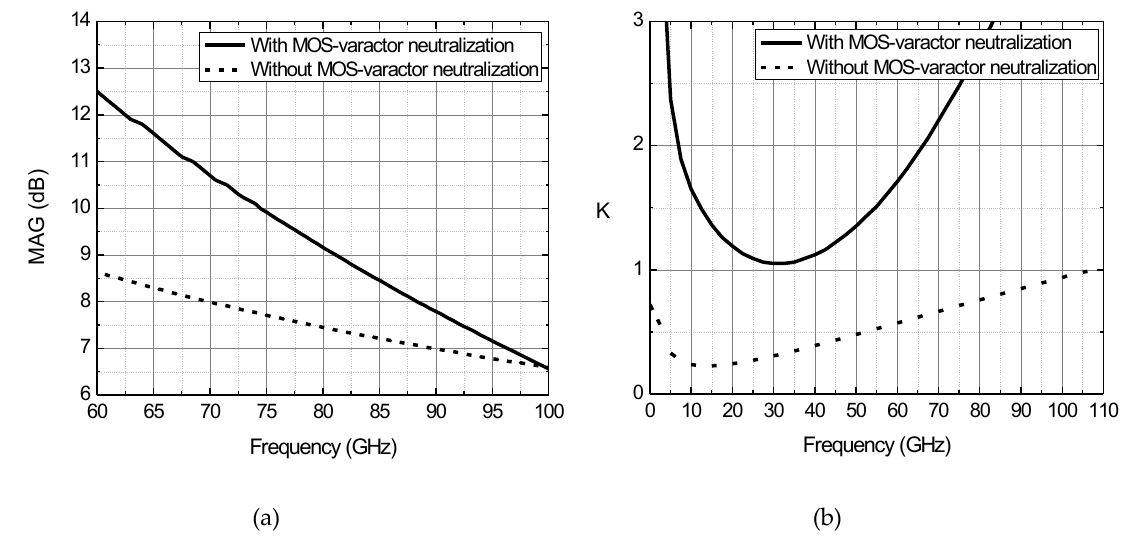
Figure 8. Neutralization effect on the W-band CS differential pair: (a) MAG; (b) K.